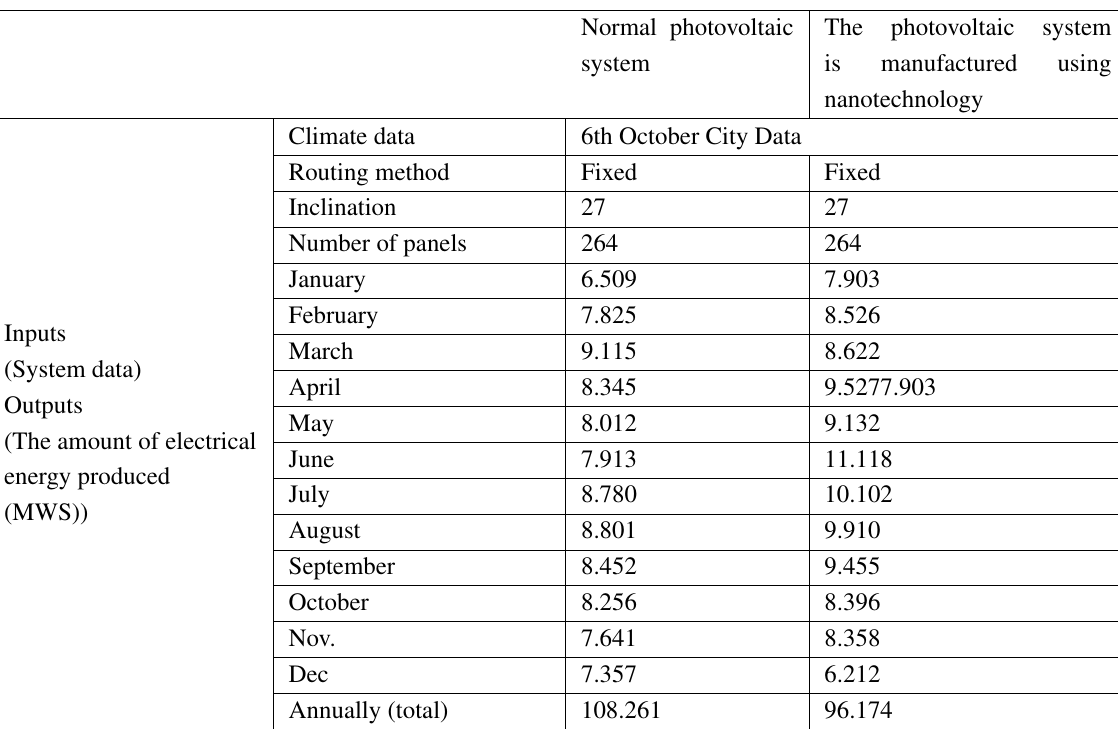
Table 3. Calculating the amount of electrical power generated by the PV system in different design cases of the system using the RET Screen Expert program and comparing it with mathematical equations (”Renewable Energy Technologies Screen”,